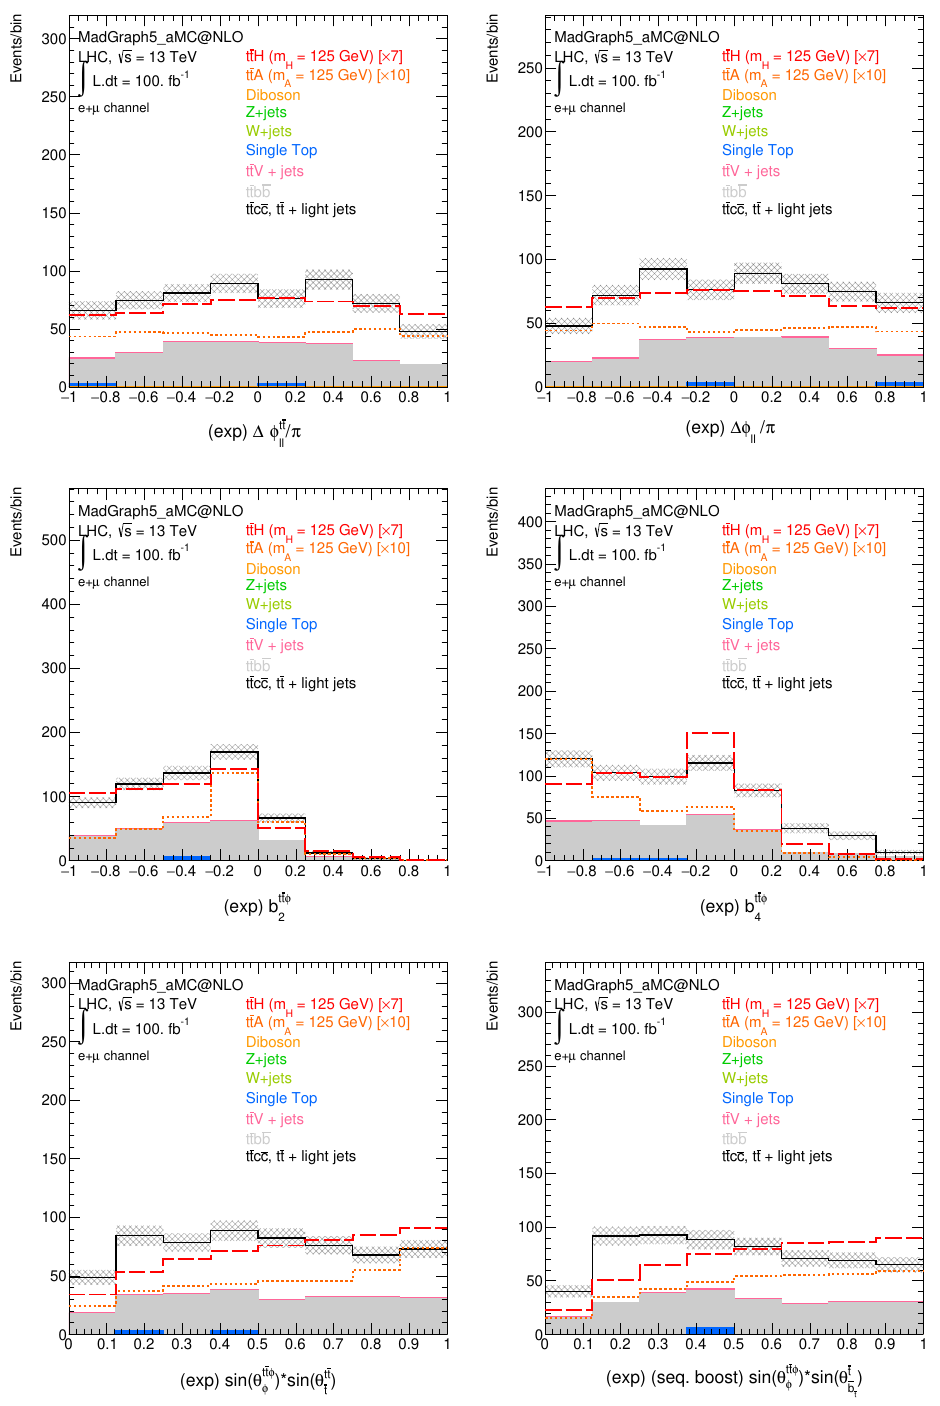
Figure 4 . Angular distributions are represented, after event selection and kinematic reconstruction, for several sensitive CP variables, in t ¯ tφ production at the LHC, for a reference luminosity of 100 fb − 1 . The t ¯ tφ CP-even and CP-odd signals, are scaled by a factor of 7 and 10, respectively, for